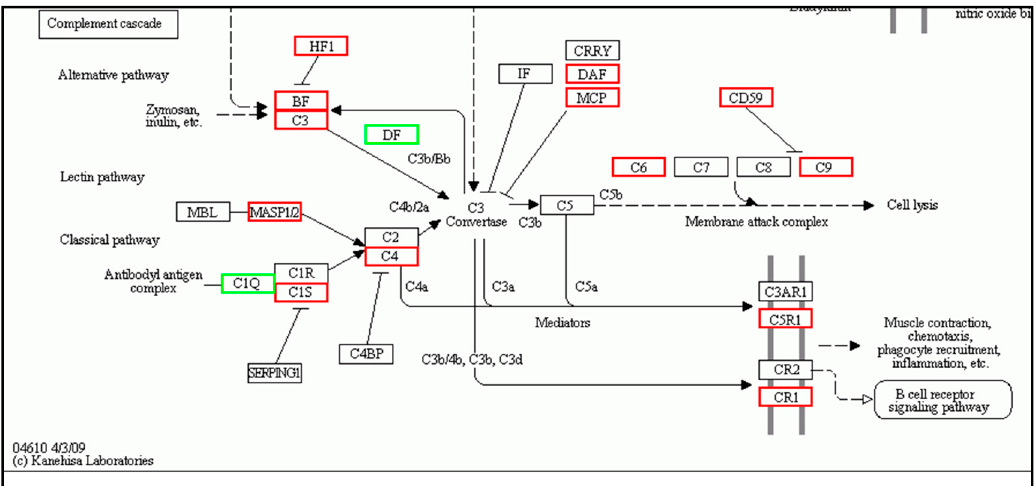
Figure 7. Complement cascade pathway mapping in muscle by KEGG. Red boxes indicate significantly differentially up-regulated expression, green box indicate down-regulated expression and white boxes indicate unchanged expression in the transcriptomic profile.